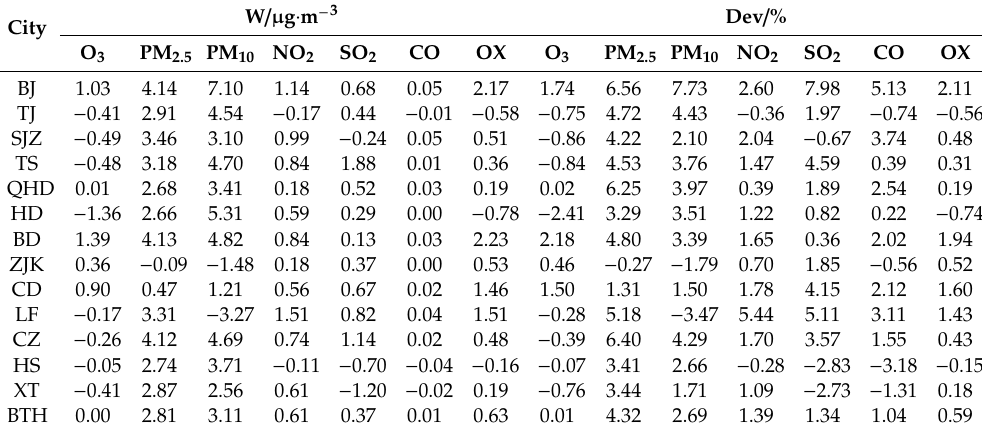
Table 2. Weekend and weekday di ff erences in O 3 and other air pollutants in BTH